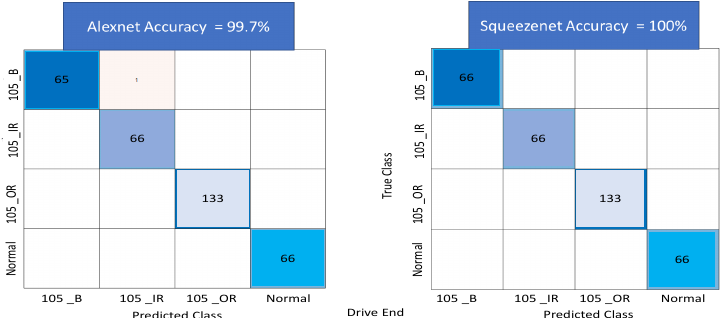
Figure 16. Figure showing Confusion Matrix for AlexNet and SqueezeNet using Transfer learning on the Color recurrence plots for the drive end bearing subset of the data set.